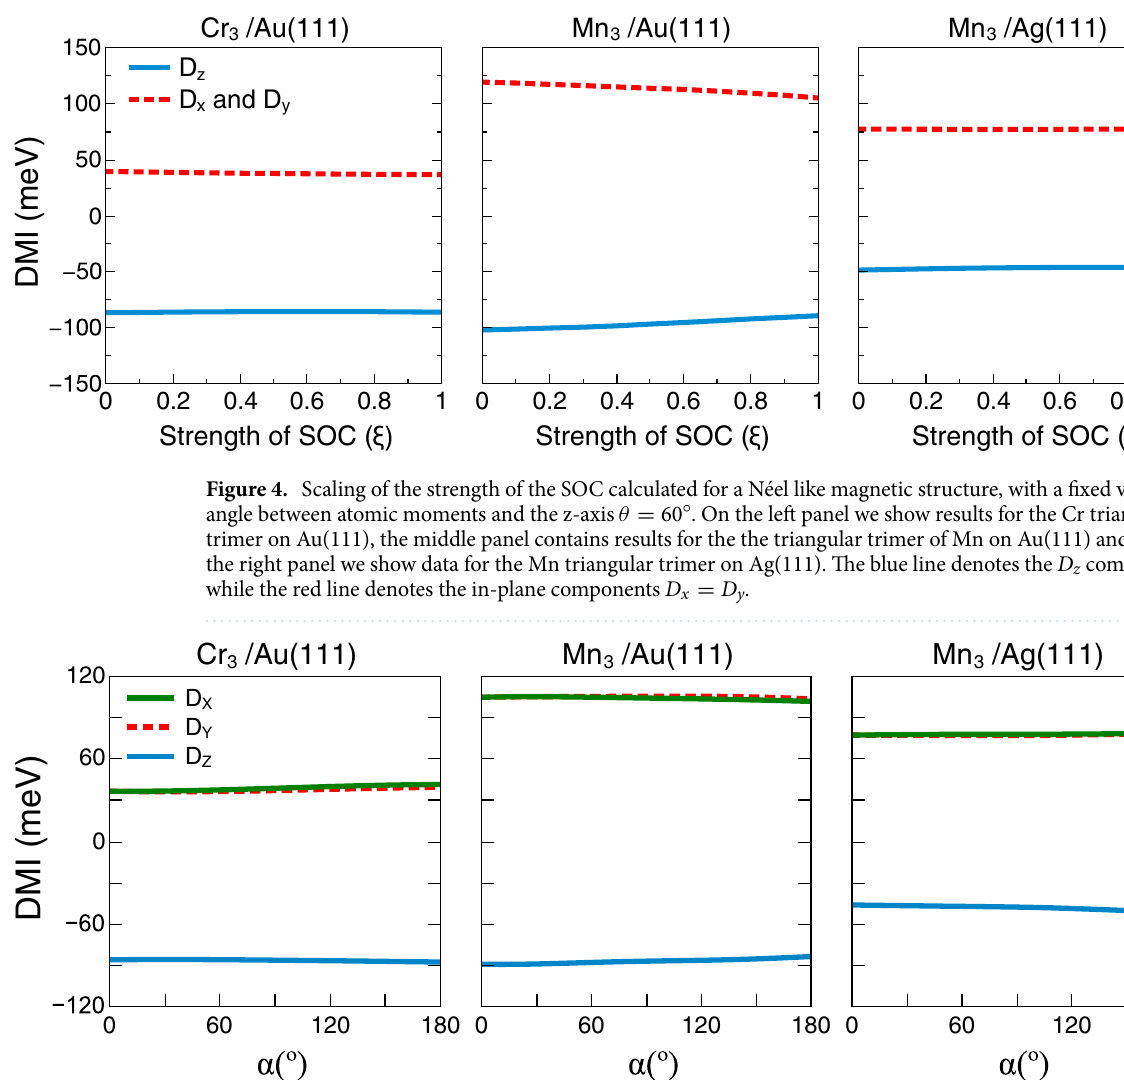
Figure 5. Calculated DMI when a global spin rotation of the magnetic structure by an angle α around the y -axis is performed. On the left panel we show results for the Cr triangular trimer on Au(111), the middle panel contains results for the triangular trimer of Mn on Au(111) and on the right panel we show data for the Mn triangular trimer on Ag(111). The green, (dashed) red, and blue lines denote the D x , D y , and D z components,